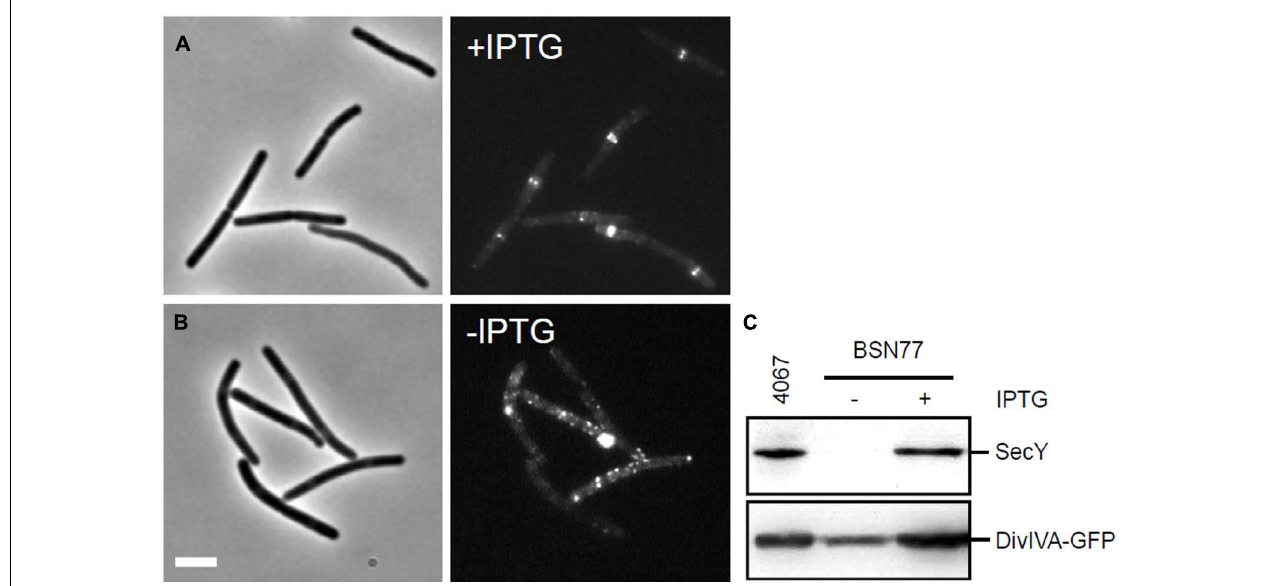
FIGURE 7 | Effect of SecY depletion on the localization of DivIVA-GFP. (A,B) Localization of DivIVA-GFP in strain BSN77 containing the inducible Pspac-secY allele. Strain BSN77 was grown in the presence (A) or absence (B) of 1 mM IPTG, and expression of divIVA-gfp was induced